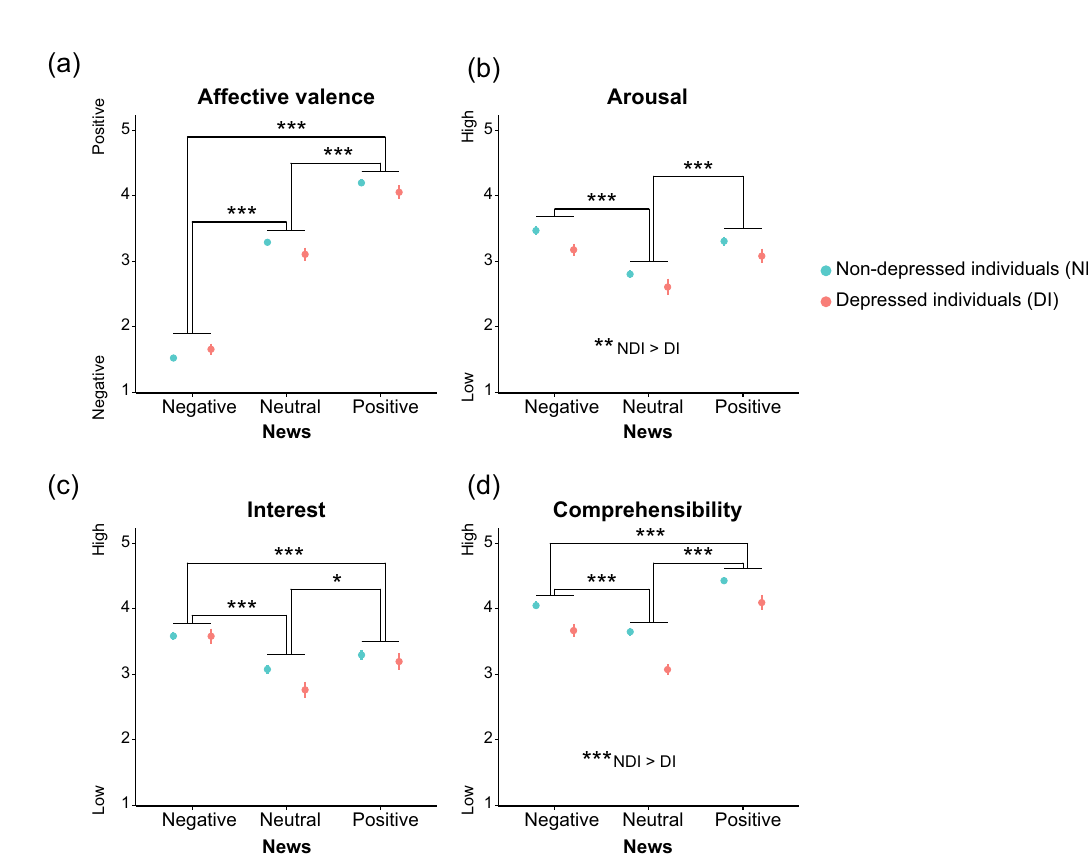
Figure 2. Differences in subjective evaluation between groups and between news. ( a ) Affective valence was higher for positive news than for neutral and negative news, and that for neutral news was significantly higher than that for negative news. ( b ) Arousal was higher for the negative and positive news than for the neutral news. There was no significant difference between the positive and negative news. In addition, the non-depressed individuals showed higher arousal than the depressed individuals. ( c ) Interest for the negative news was higher than that for the positive and neutral ones did, and that interest for the positive news was higher than neutral one. ( d ) Comprehensibility for the positive news was higher than those for the negative and neutral news, and comprehensibility for the negative news was higher than that for the neutral news. In addition, the news was more comprehensible for non-depressed individuals than for depressed individuals. Each circle and error bar represent the mean and standard error, respectively. * p < 0.05, ** p < 0.01, and *** p <